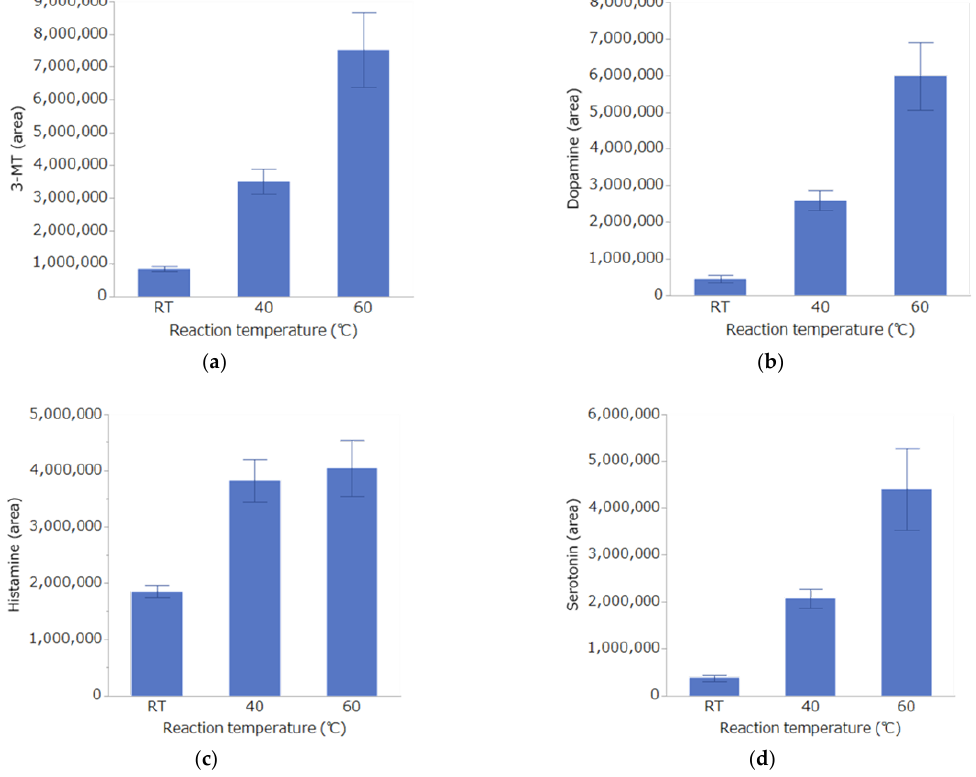
Figure 4. Effect of reaction time on derivatization with DPP. Detection of 3-MT ( a ), dopamine ( b ), histamine ( c ), and serotonin ( d ) by LC-MS/MS. Bar graphs indicate the mean ± SE of each condition ( n = 5 per condition).